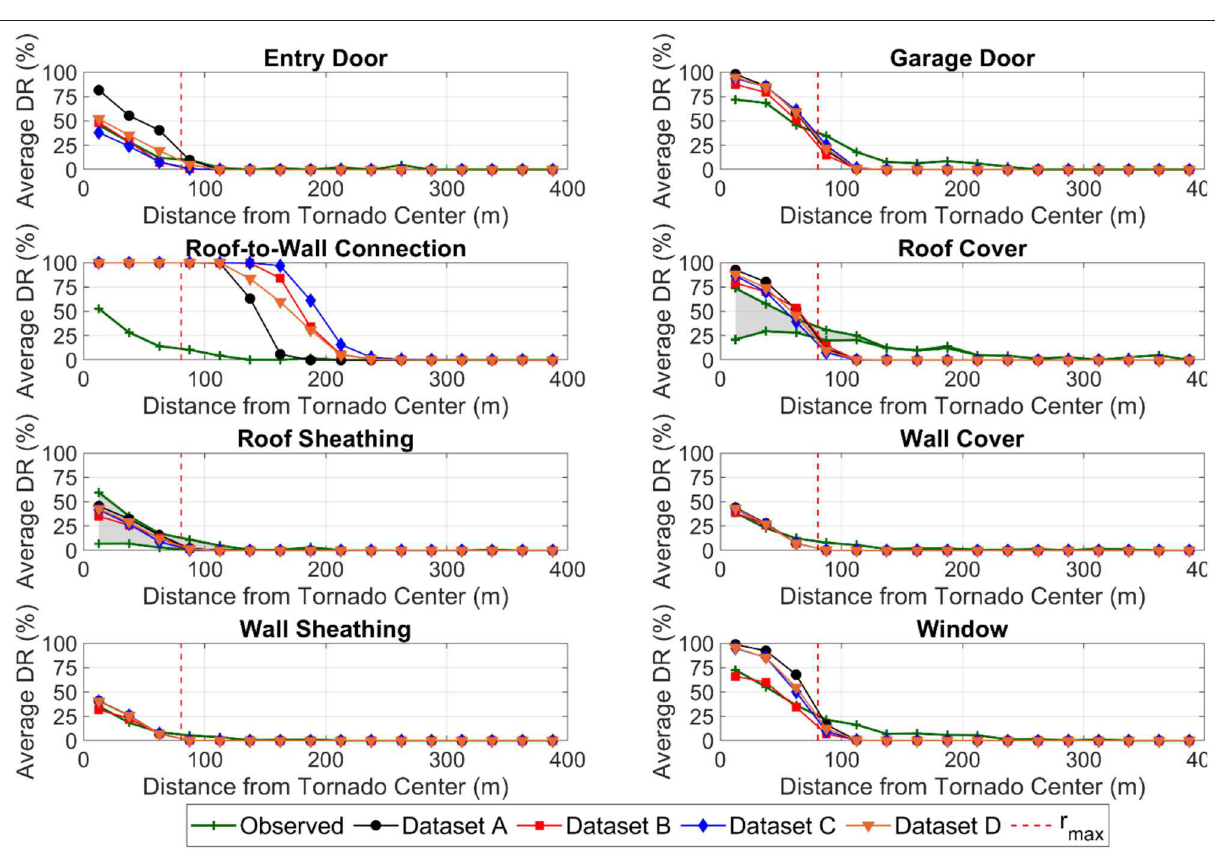
FIGURE 4 | Average observed and ETDA Tool predicted damage ratios (DR) for the Garland/Rowlett tornado. Bin size is 25m. The red dashed line indicates the radius to maximum wind speeds (RMW). Gray shaded regions show the lower to upper bound ranges for observed damage ratio for roof sheathing damage ratio and roof cover damage